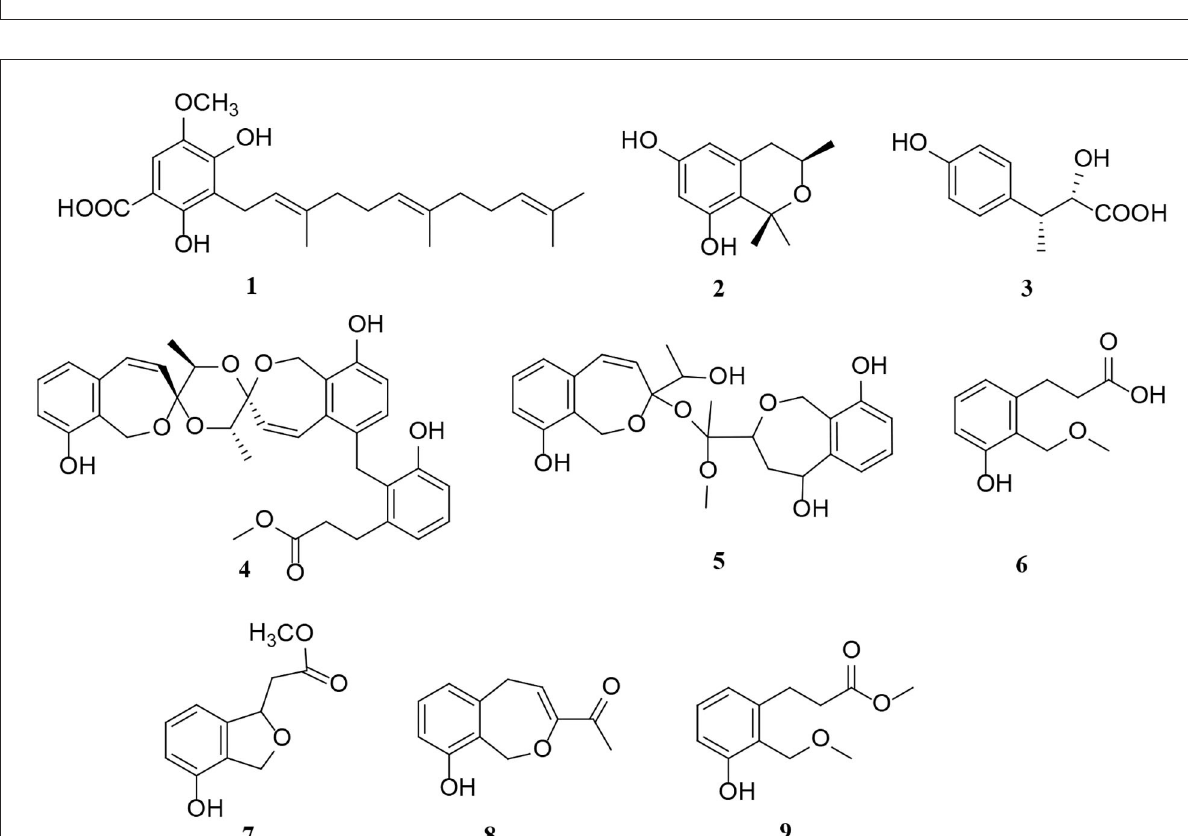
FIGURE2 Simple phenylpropanoid derivatives ( 1 – 9 ) from Alternaria